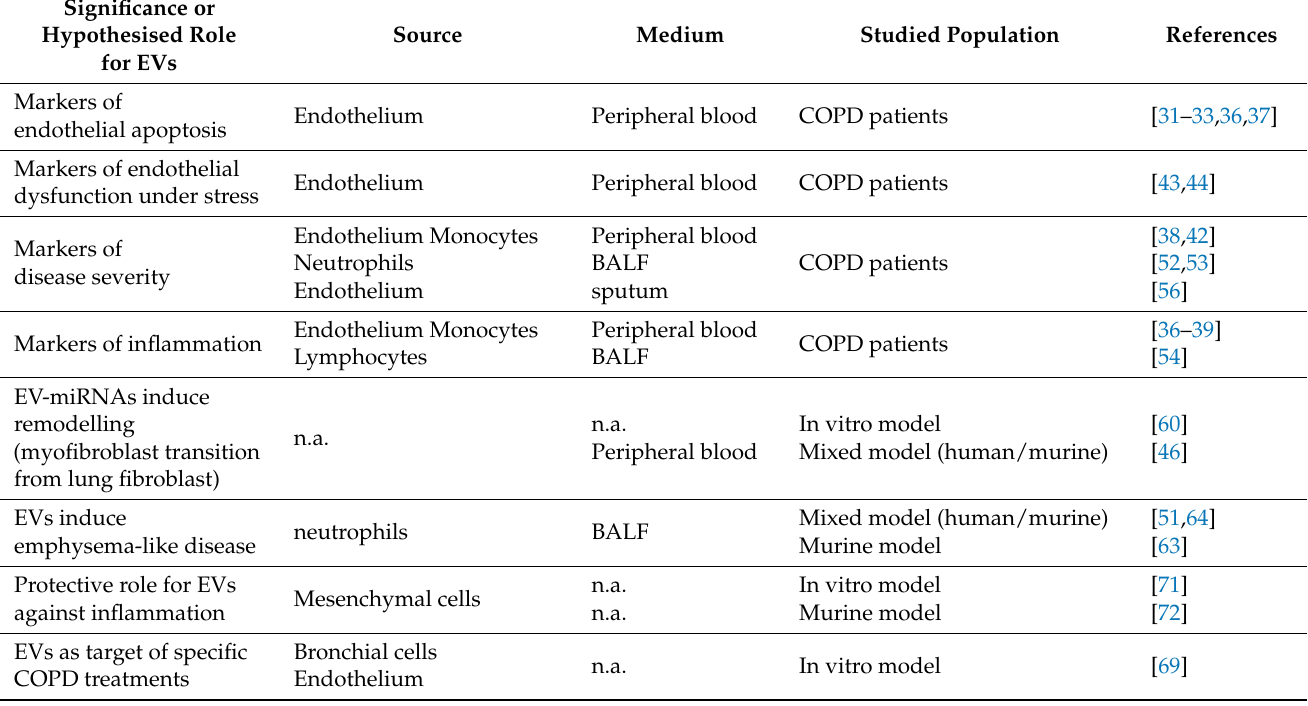
Table 1. Main findings about EVs in patients affected by COPD and in cellular or animal models if the